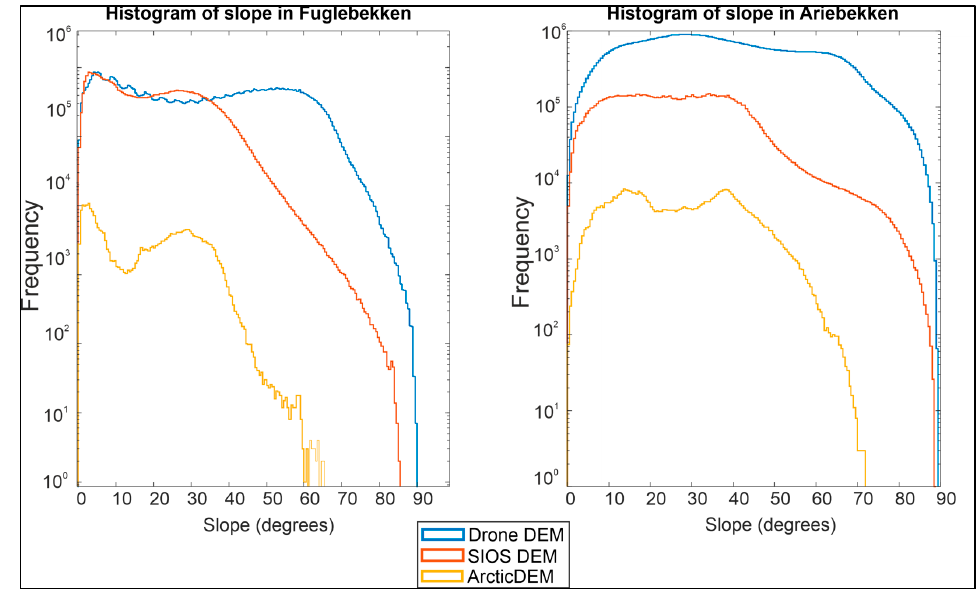
Figure 12. Slope distribution of three DEMs in Fuglebekken and Ariebekken (note that the lower resolution of DEM causes skewness towards lower values).